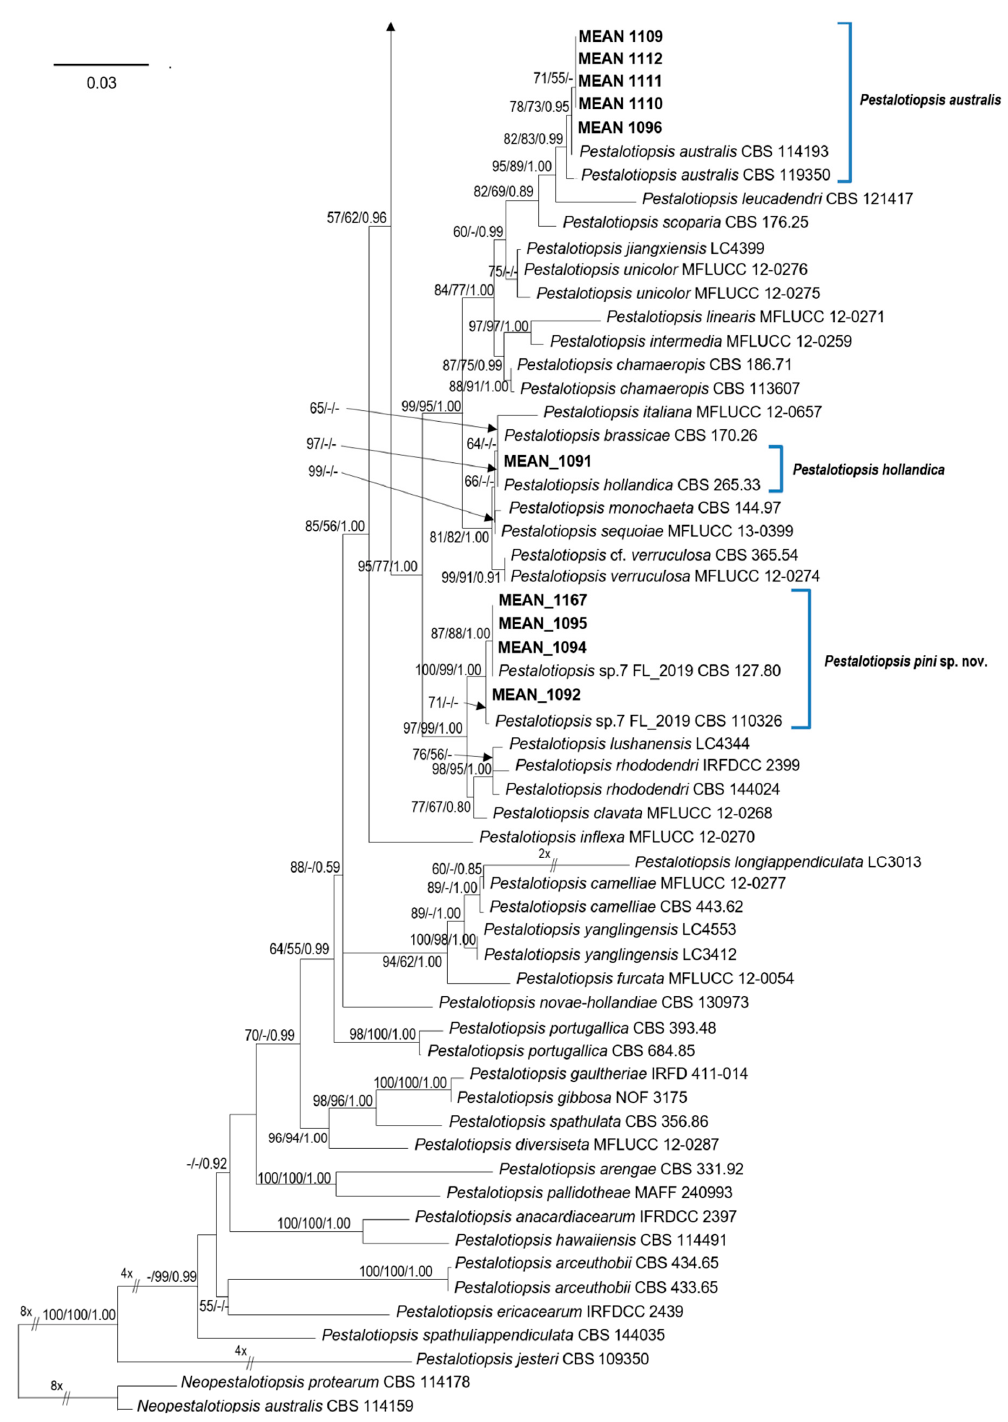
Figure 1. Cont . Figure 1. Phylogram generated from maximum likelihood (ML) analysis based on combined ITS, TUB and TEF sequence alignment for species of Pestalotiopsis. The best scoring ML tree with a final likelihood value of − 10,646.254559 is presented. The tree was rooted to Neopestalotiopsis australis (CBS 114159) and N. protearum (CBS 114178). Maximum likelihood and maximum parsimony bootstrap support values ≥ 50% and Bayesian Inference posterior probabilities ≥ 0.90 (MLBS / MPBS / BIPP) are given at the nodes in common branches. The isolates obtained in this study are in bold. The scale bar represents the expected number of changes per